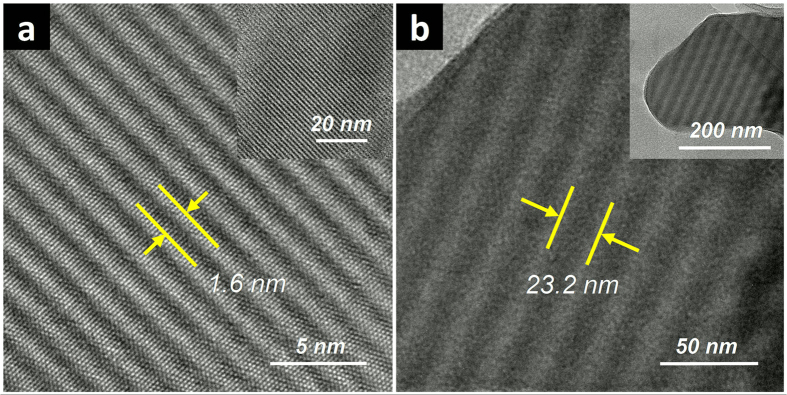
TEM images of parallel-line like Moiré fringes from BNNS vdW superstructures.Shown in the insets are the corresponding zoom-out images at lower magnifications.